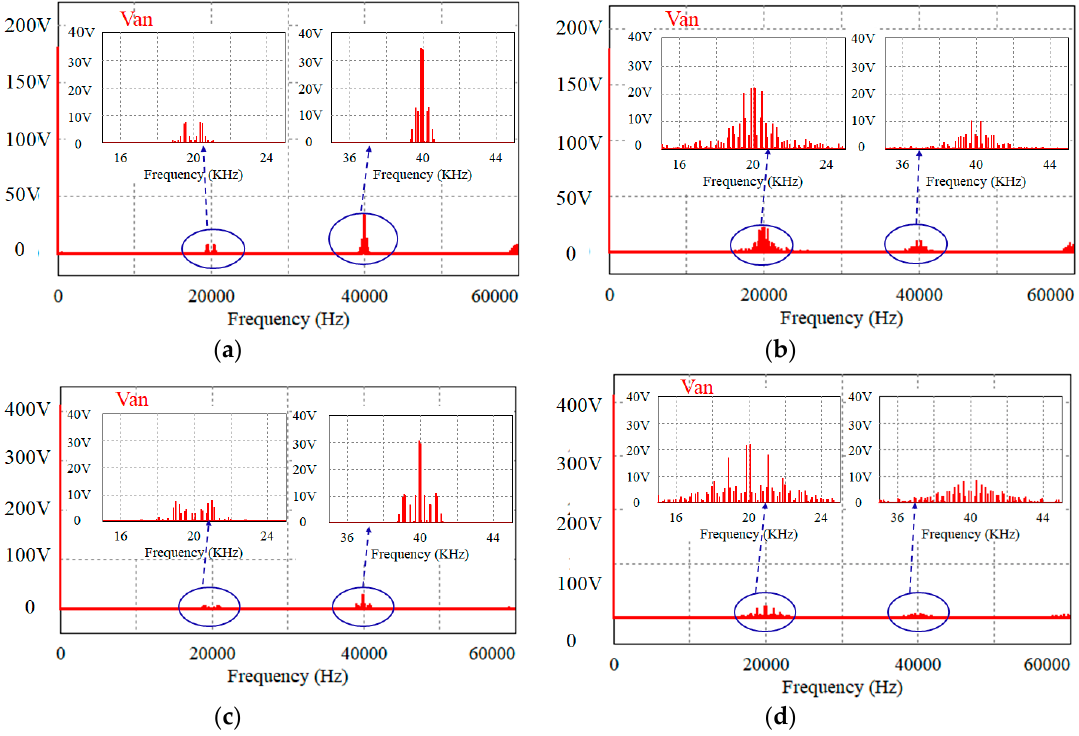
Figure 6. Harmonics spectrum of phase voltage at f s = 20 kHz using ( a ) sinPWM method with m = 0.4, ( b ) proposed method with m = 0.4, ( c ) sinPWM method with m = 0.9, and ( d ) proposed method with m = 0.9.